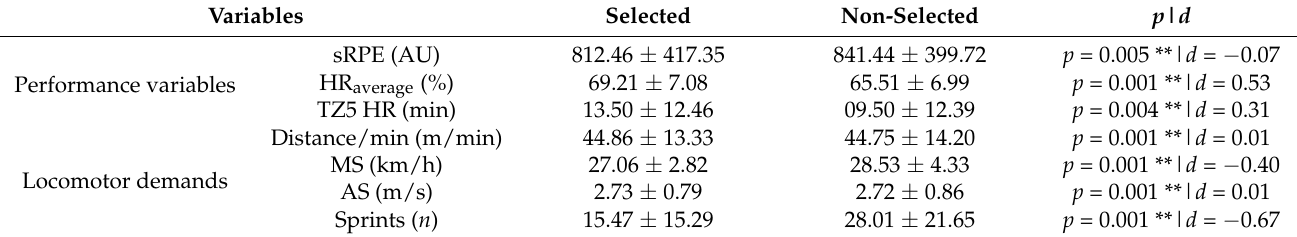
Table 5. Performance variables (sRPE, HR average , VO2 max , and TZ5 HR) and locomotor demands (dis/min, MS, AS, and S) recollected in different training camps (TC. 2 days, TC. 3 days, TC. 4 days,